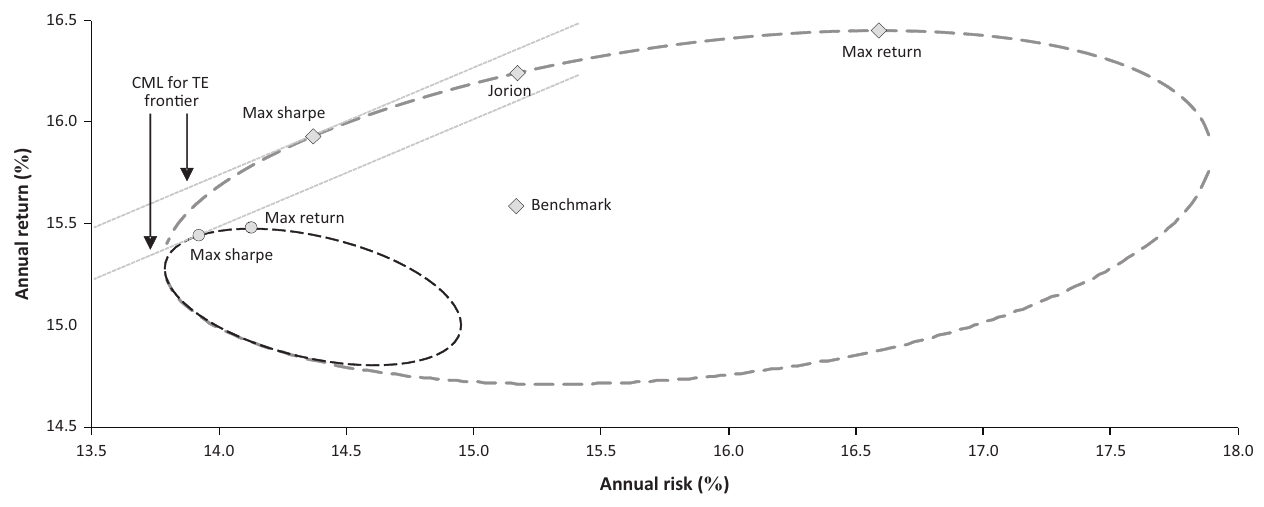
FIGURE 6: Impact of weight constraints on investable portfolios. Note the truncated